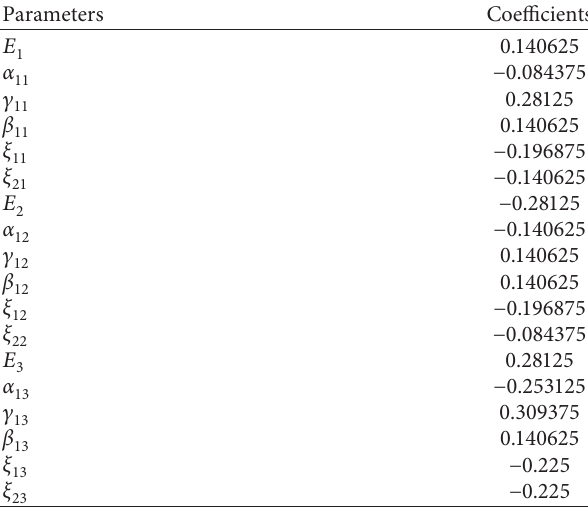
Table 2: The parameters used for the fuzzy-EGARCH-ANN model to simulate data.